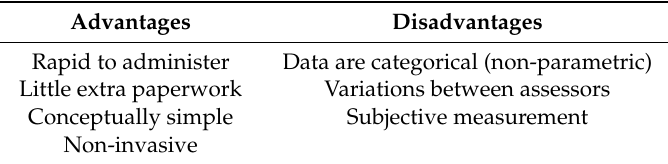
Table 2. Advantages and disadvantages of simple descriptive pain